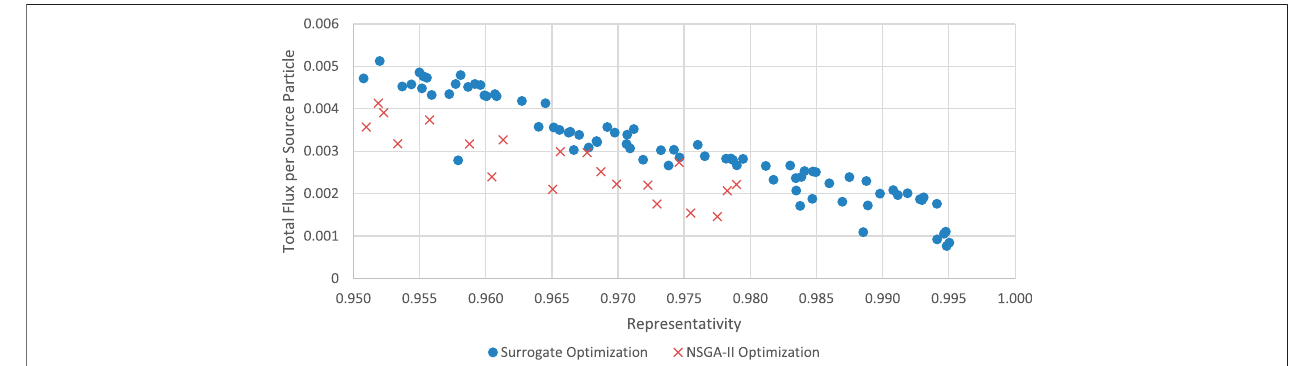
FIGURE 7 | Comparison of Pareto Front Individuals from Both Optimizations, Total Flux vs. Representativity.